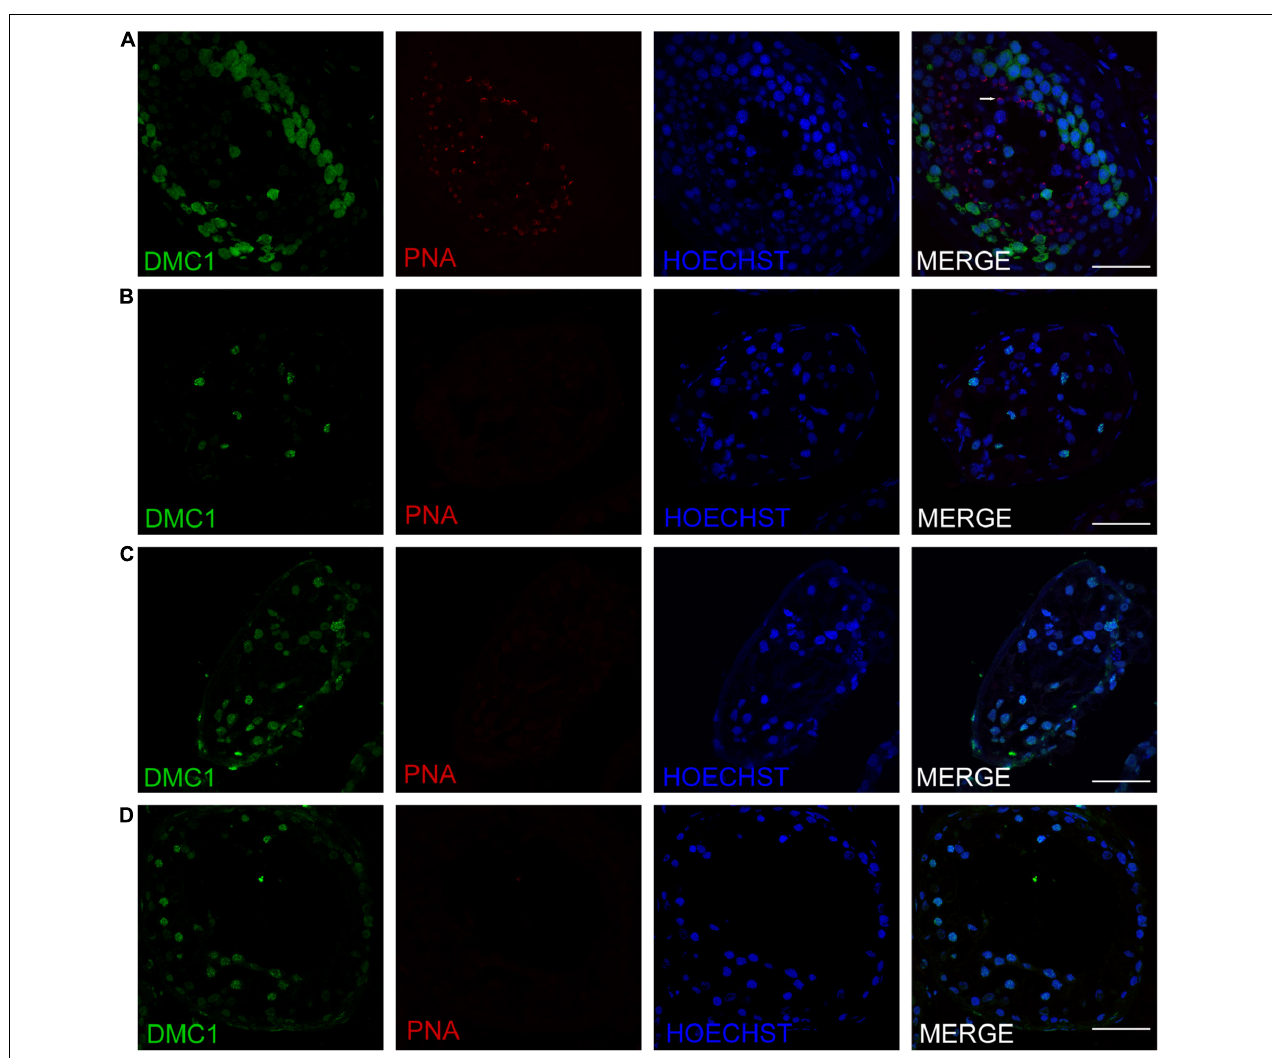
FIGURE 5 | Expression of recombination proteins DMC1 and acrosomal marker PNA in the testis of affected patients and a patient with obstructive azoospermia as a positive control. Immunohistochemical staining showed the expression of DMC1 (green) and PNA (red) in the testis of the patient with OA as positive control (A) , the P5648 (B) , the P6825 (C) , 7583 (D) . Scale bars = 50 µ m in panels (A–D) . Arrow indicates the acrosome of spermatids in the